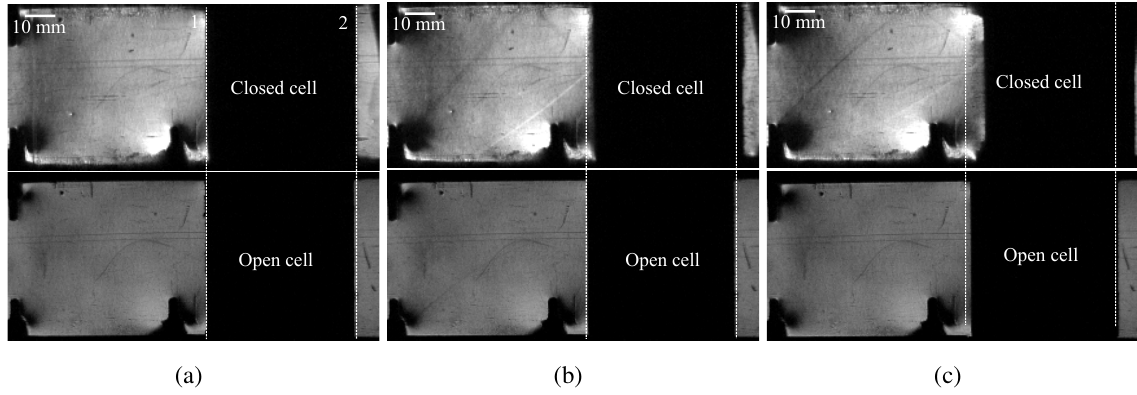
Figure 16. Photographs showing translation of the NC open and closed cell foam sample. The dashed Lines 1 and 2 represent the original locations of the front and the rear end of the foam block, respectively. ( a ) t = 0 µ s, both samples; ( b ) t = 502 µ s (closed foam), t = 500 µ s (open foam); ( c ) t = 702 µ s (closed foam), t = 710 µ s (open foam).